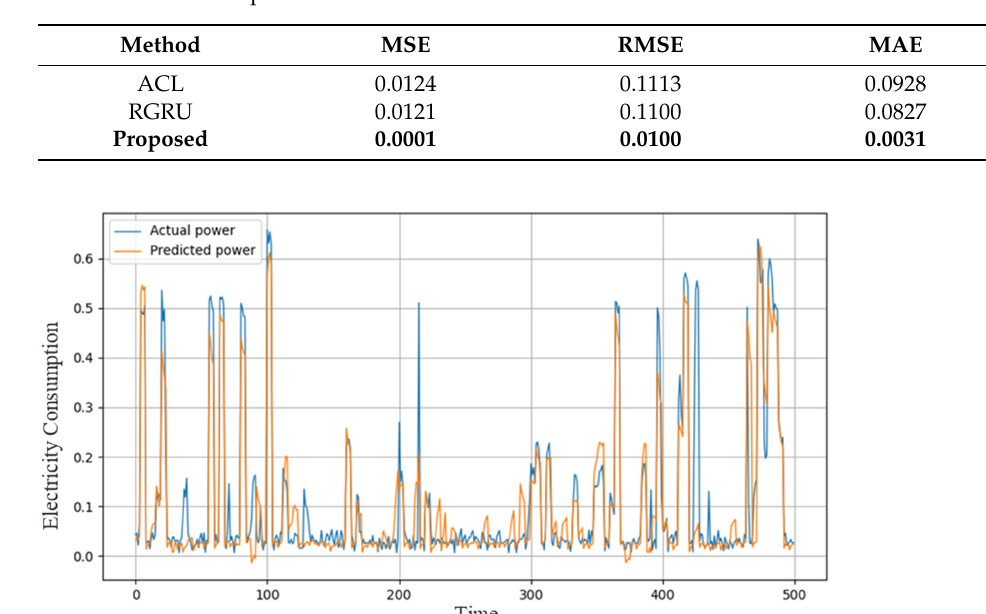
Figure 8. Performance of the proposed model over the KCB